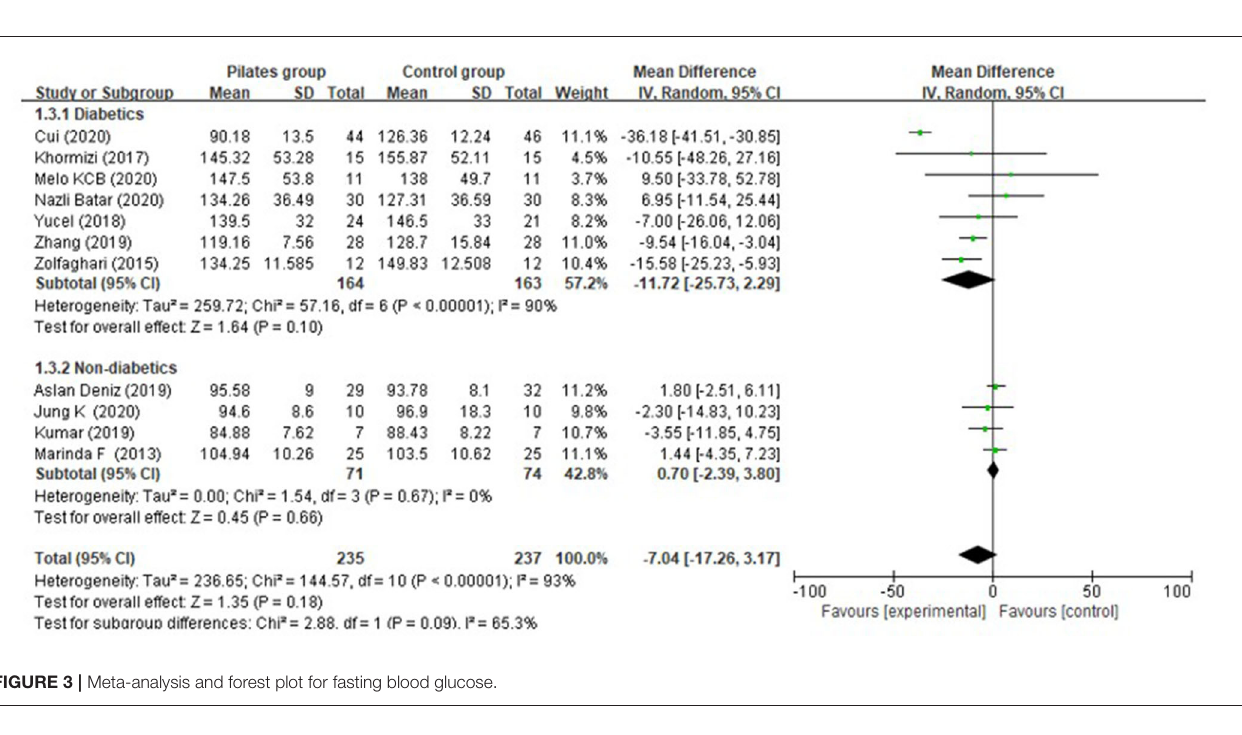
FIGURE 2 | Risk of bias graph.